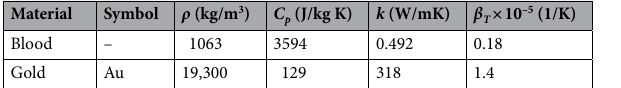
Table 1. Thermophysical parameters of blood and gold nanoparticles 39,53 .